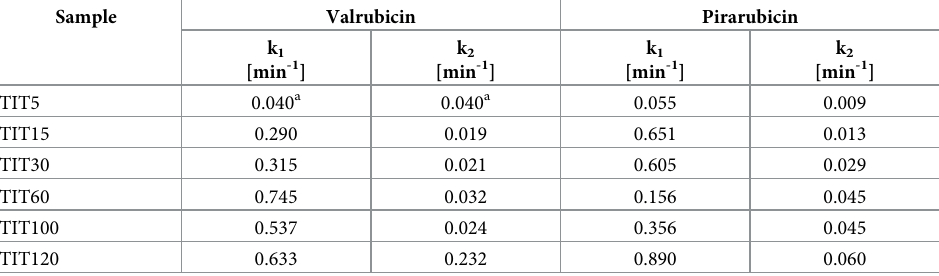
Table 3. Parameters of the pseudo-first-order kinetic model for the adsorption of anthracycline cytostatics on TiO 2 sorbents.